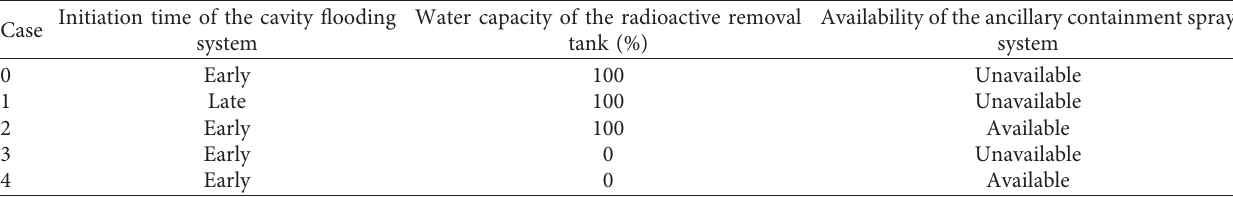
Table 1: Characteristics of the analysis cases.